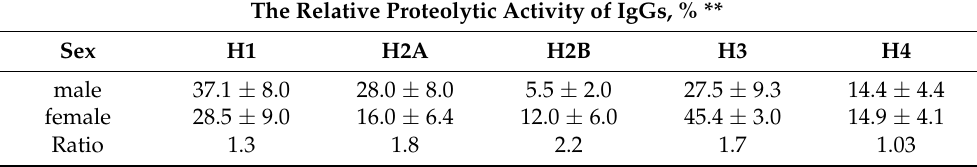
Table 2. The average relative protease activity of male and female mice IgGs at three months of age in the hydrolysis of different individual histones